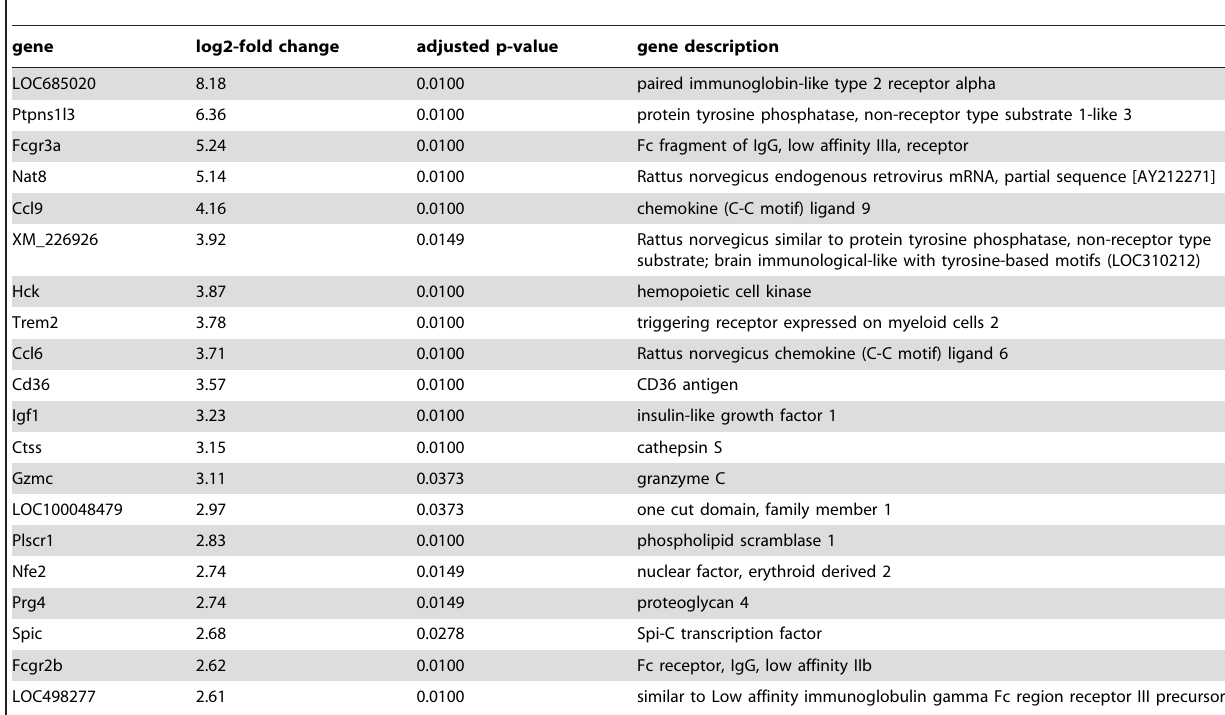
Table 1. The 20 most strongly regulated non-MHC/non-NKC genes in allogeneic skin explants compared to syngeneic controls as revealed by the microarray experiment.